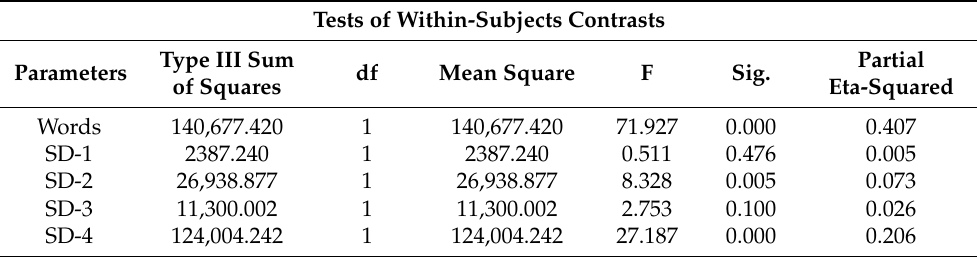
Table 7. Comparison of the reaction time for non-words and target